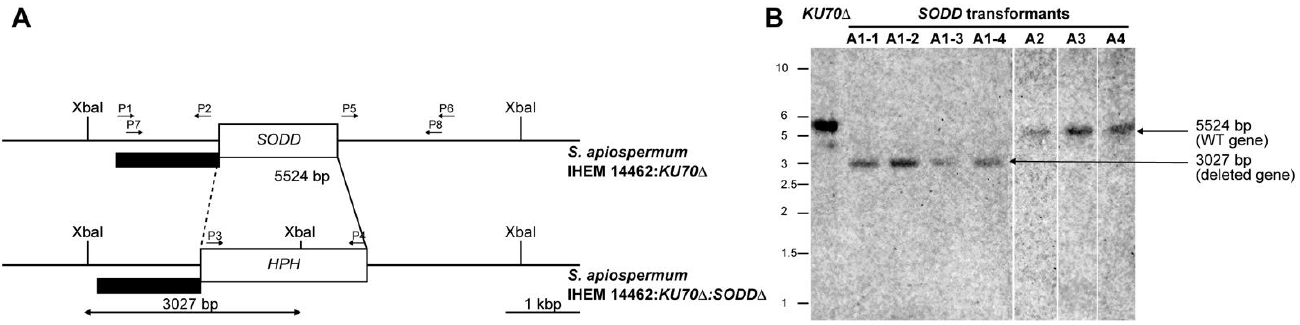
Figure 1. Production and Southern blot validation of the KU70 ∆ /SODD ∆ mutant. ( A ): Restriction map of S. apiospermum SODD locus and strategy of construction of the disruption cassette. XbaI restriction sites are indicated, and the black box indicates the hybridization site of the probe (upstream region of the SODD gene). The size of the expected fragments is indicated by arrows. P1, P2, P3, P4, P5, P6, P7, and P8 correspond to the primers used for the construction of the disruption cassette. ( B ): Genomic DNA of the wild-type strain IHEM 14,462 (WT) and SODD transformants A1, A2, A3, or A4 were digested by XbaI. The 5.5-kbp band corresponding to the SODD wild-type locus was seen for the wild-type strain and SODD transformants A2, A3, and A4, but not for the A1 transformant, which showed a 3-kbp band demonstrating the disruption of the SODD gene by the HPH resistance gene.